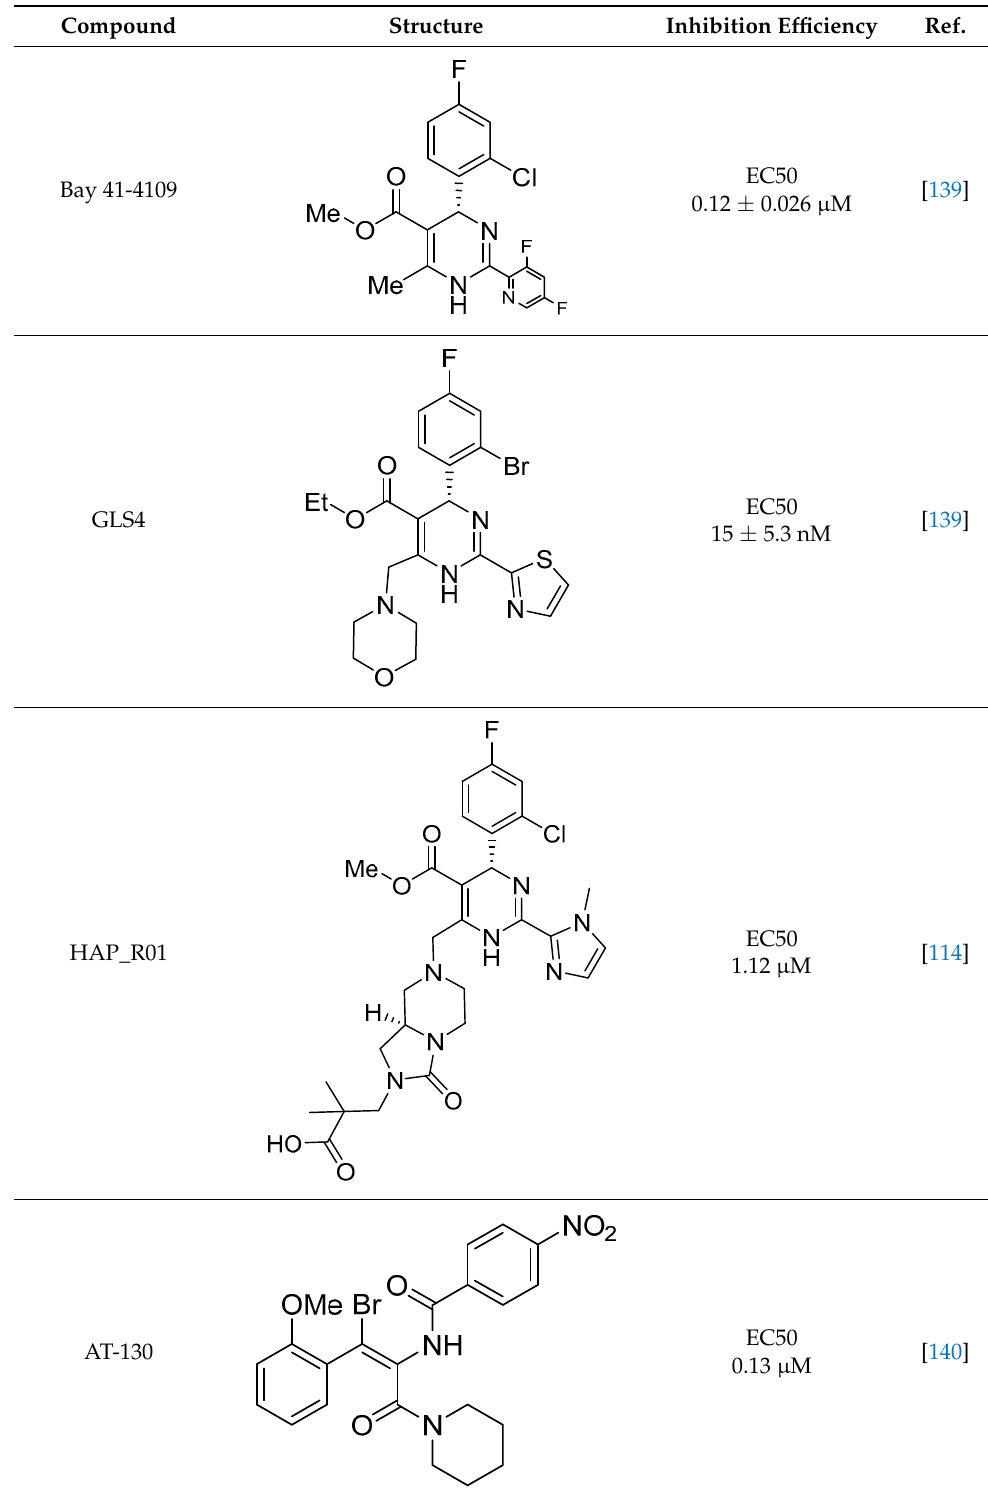
Table 2. List of hepatitis B virus assembly inhibitors. Compound Structure